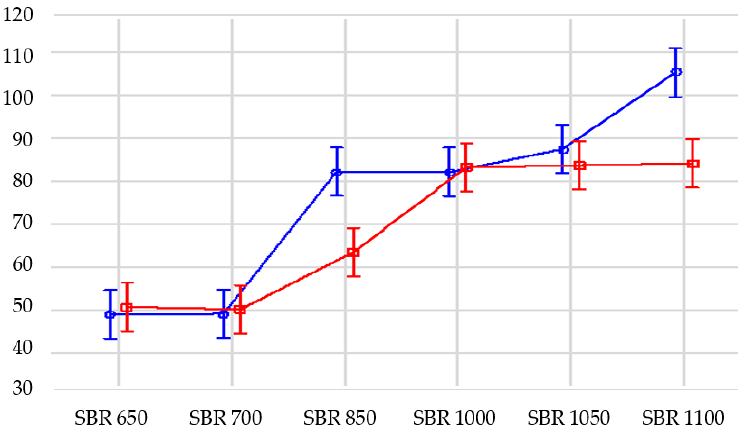
Figure 13. Influence of density on elongation at break of the samples for two analyzed conditions: blue line—1 (normal conditions), red line—2 (ageing conditions).